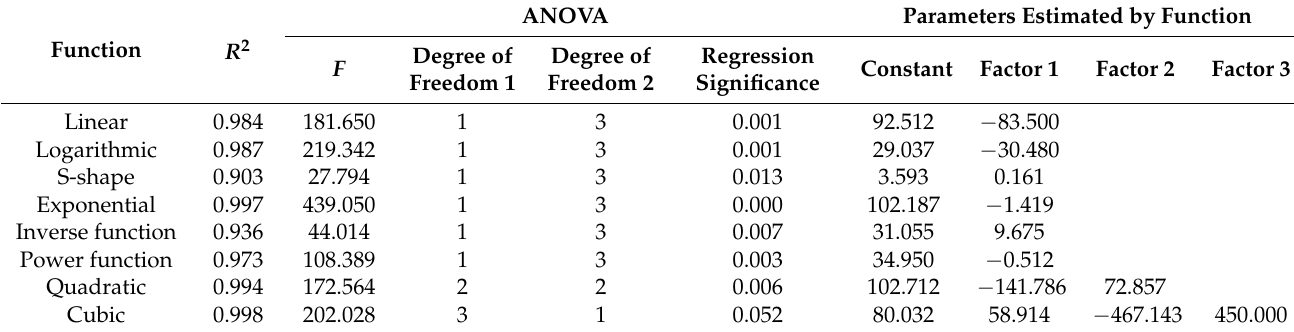
Table 3. Fitting results of air pressure and SMD.